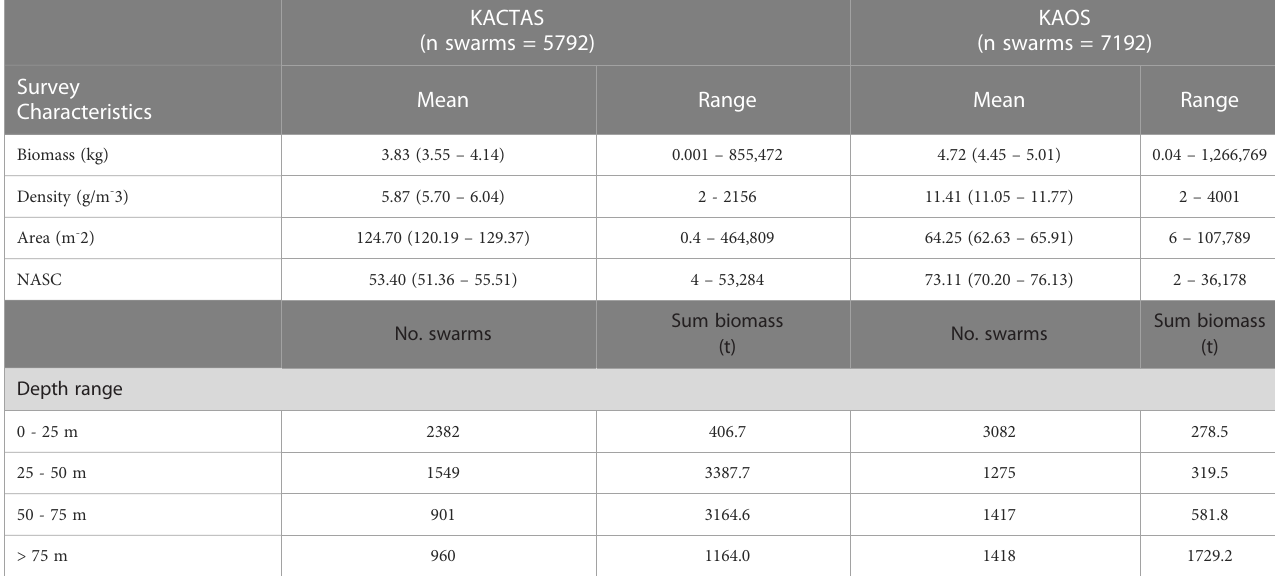
TABLE 2 Summaries of physical properties of krill swarms and the depth-strati fi ed total number of swarms and biomass recorded during KACTAS and KAOS voyages that occurred over the entire survey area.